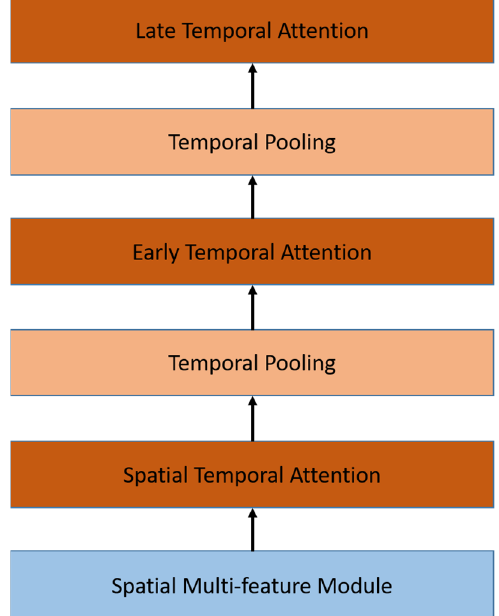
Figure 7. Attention modules are embedded in spatial and temporal modules in different configura- tions.